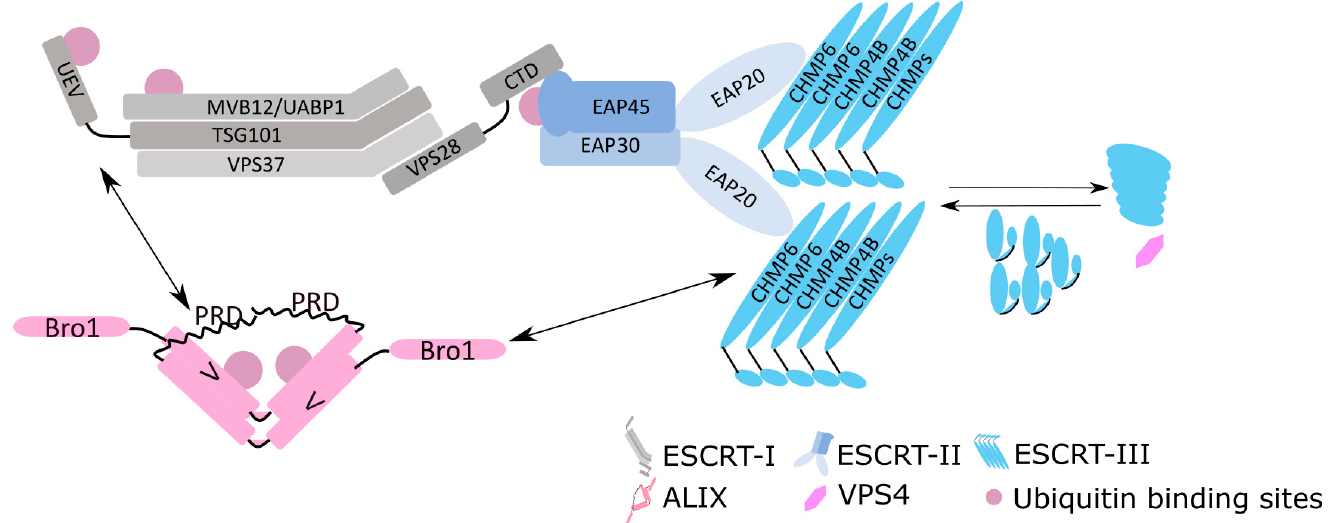
Figure 1. Schematic diagrams of the mammalian core ESCRT protein complexes. Direct contacts are made to show the interaction among the ESCRT components e.g., VPS28 and EAP45, and EAP20 and CHMP6. Double-headed arrows denote the intermolecular interactions between ALIX and TSG101 and ALIX and CHMP4B.